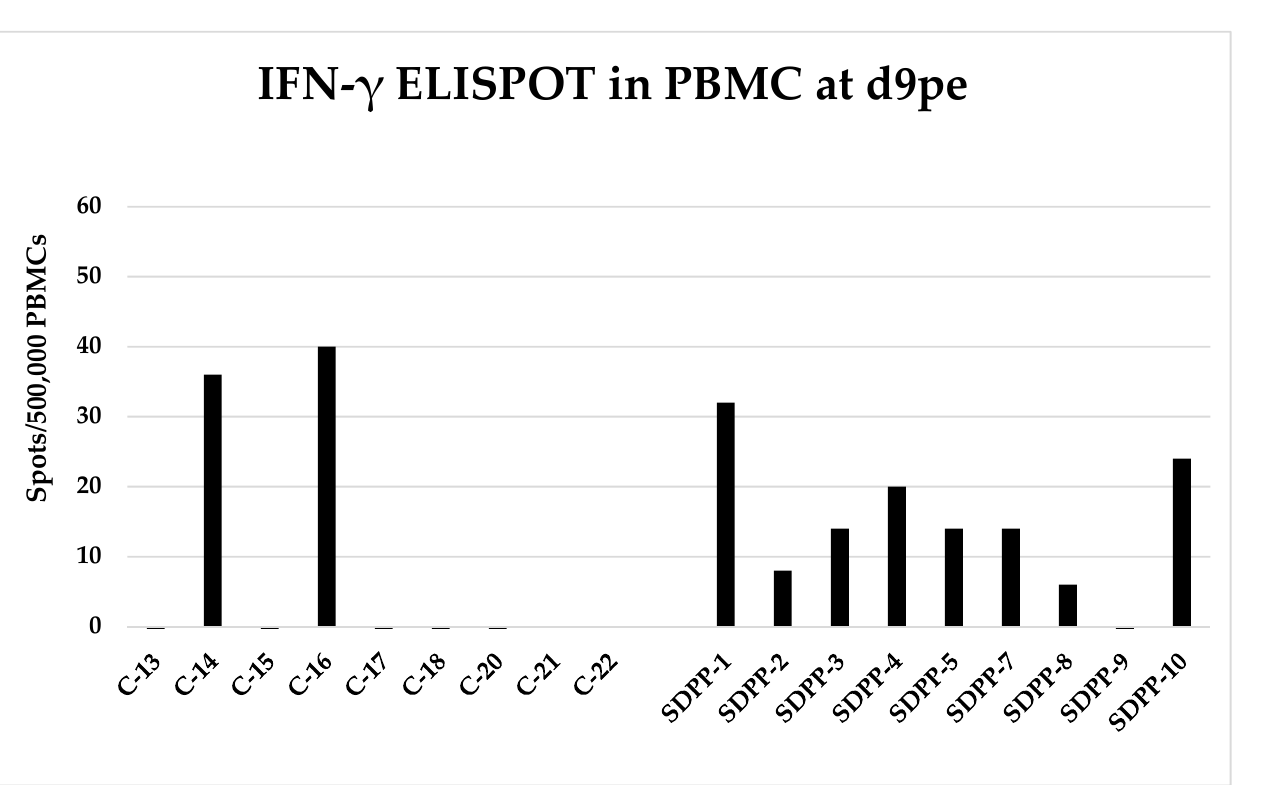
Figure 6. ASFV-specific IFN- γ secreting cells analyzed by ELISPOT at 9 days after first ASFV encounter (d9pe). PBMC from d9pe were stimulated in vitro with Georgia 2007/1 at MOI 0.2 and the number of ASFV-responding IFN- γ -secreting cells was quantified by ELISPOT. Values shown are individual values subtracting the corresponding values of mock-stimulated cells. C-#: Animals in CONVENTIONAL diet; SDPP-#: animals in spray-dried porcine plasma (SDPP) diet.